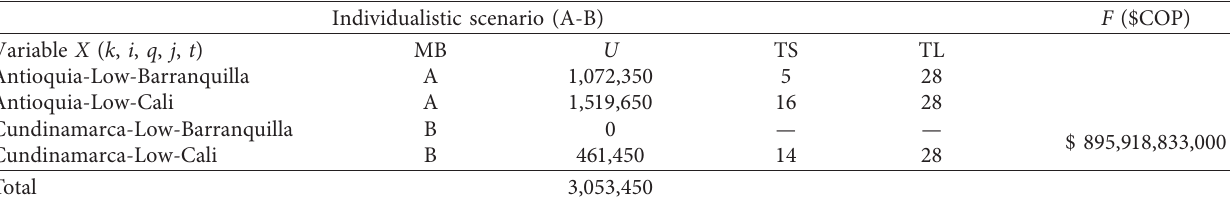
Table 2: Results of the programming model under scenario 1.